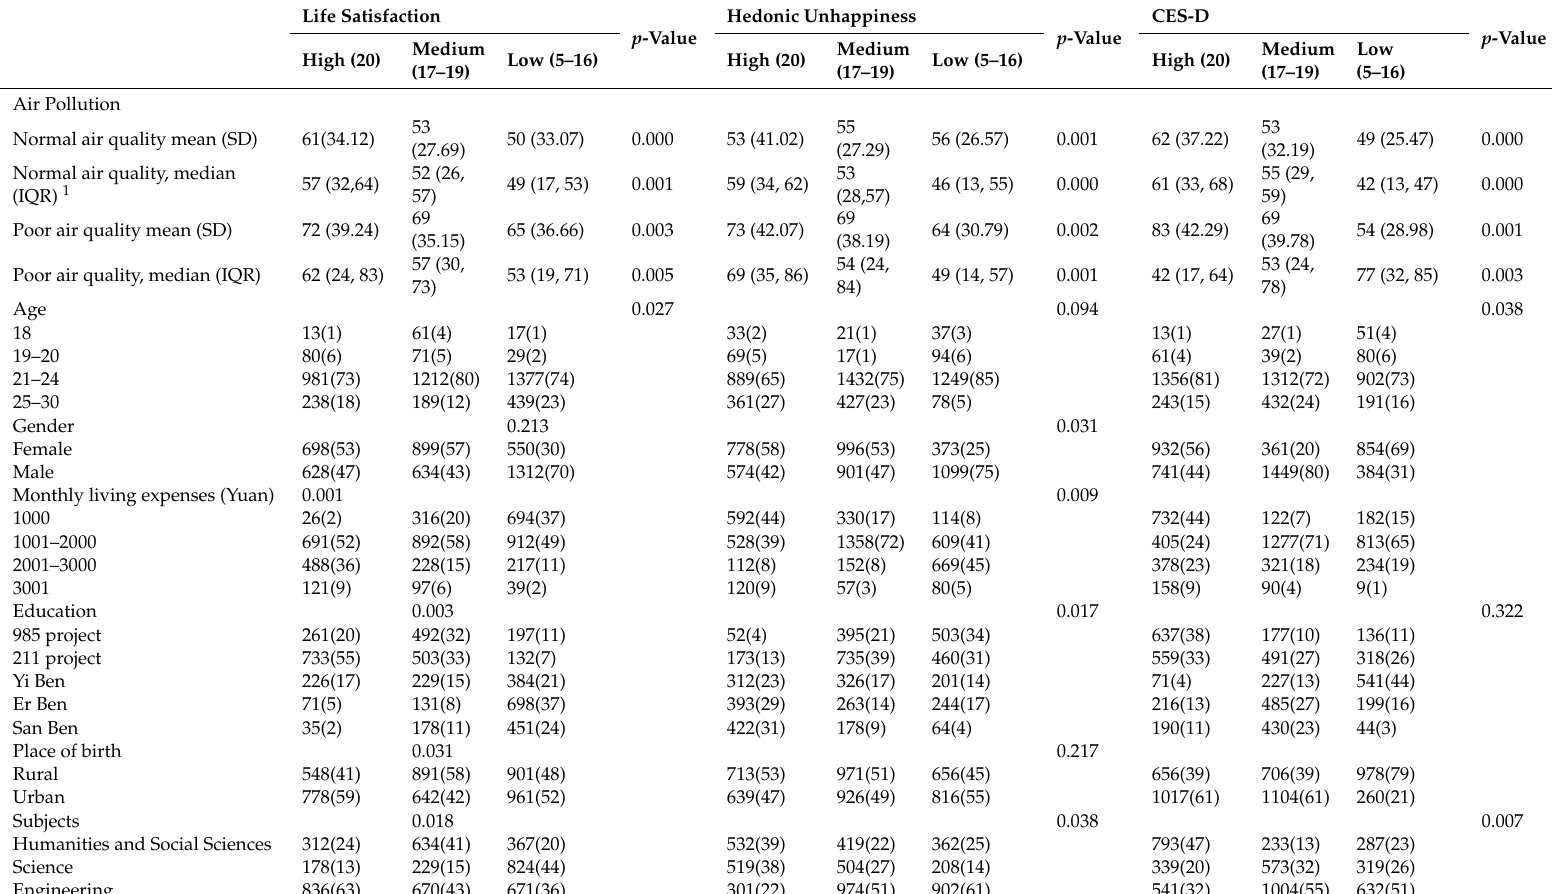
Table 2. Whole sample characteristics and bivariable